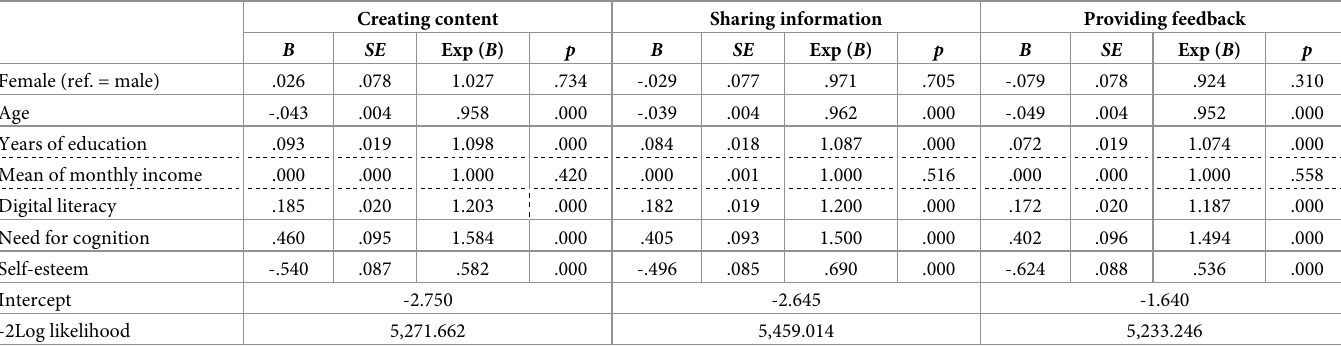
Table 2. Logistic regression of creating, sharing, and